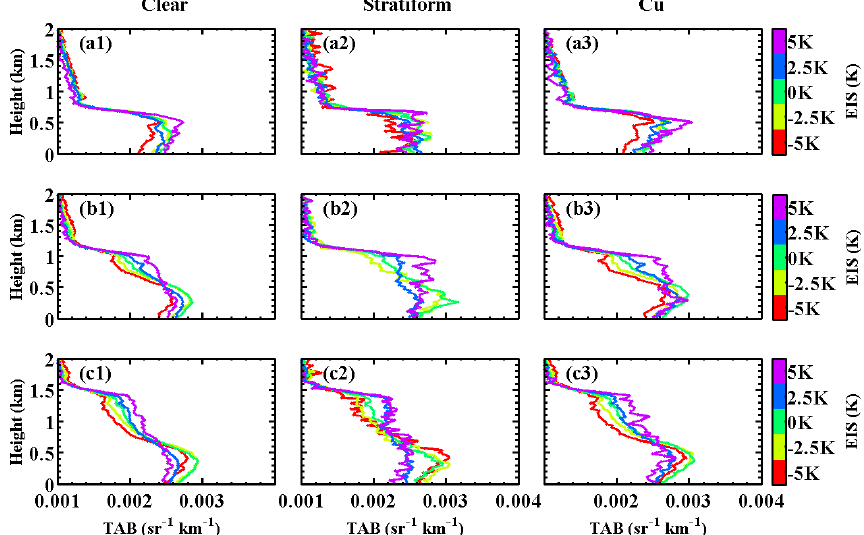
Figure 7. Mean MBL CALIOP TAB structure under different conditions from 4-year climatology over the eastern Pacific Ocean: 0.6km < BLH < 0.8km (a1, a2, a3) , 1km < BLH < 1.2km (b1, b2, b3) , and 1.4km < BLH < 1.6km (c1, c2, c3) . (a1, b1, c1) are under the clear conditions that are defined as totally cloud free over a 0.25 ◦ AMSR-E footprint; (a2, b2, c2) are under the stratiform cloud conditions that are defined as with only stratiform cloud and clear sky in each 0.25 ◦ AMSR-E footprint; (a3, b3, c3) are under the Cu cloud conditions that are defined as with only Cu cloud and clear sky in each 0.25 ◦ AMSR-E footprint. Only results with 5ms − 1 <U 10m < 8ms − 1 were